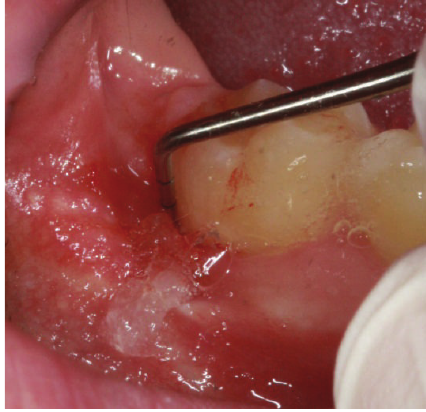
Figure 2: Preoperative clinical photograph of thelower rightsecond molar.